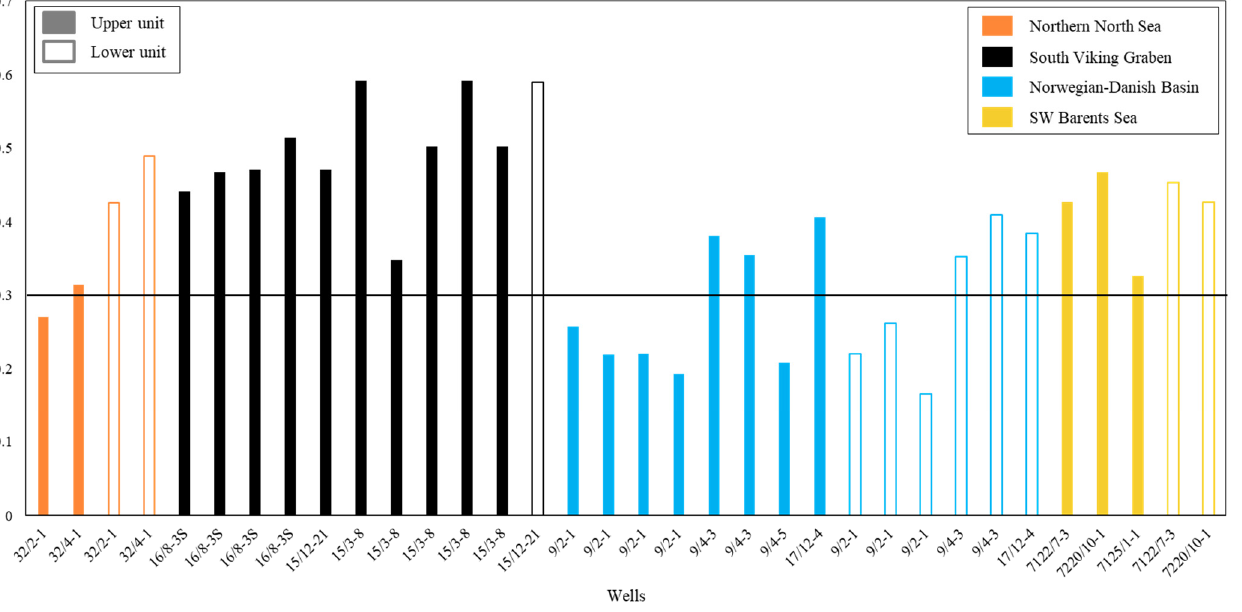
Figure 5. Mineralogical brittleness indices of upper and lower units of various wells from different sub-basins in the North Sea and SW Barents Sea.